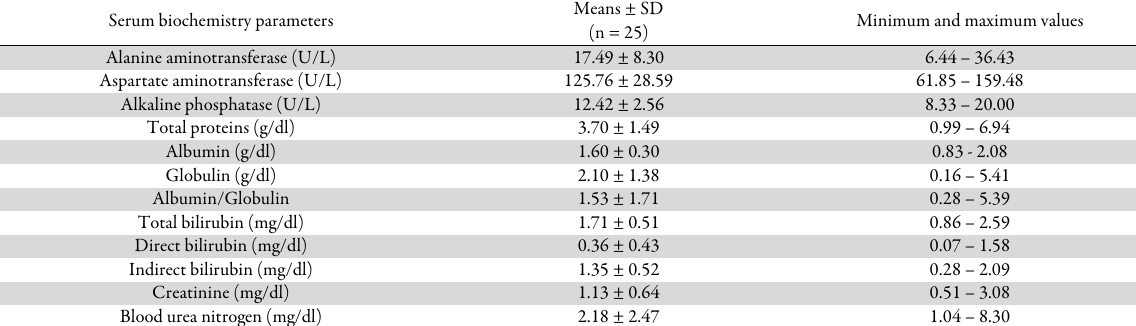
Table 1. The serum biochemistry profile of the broodstock African catfish ( Clarias gariepinus ) Serum biochemistry parameters